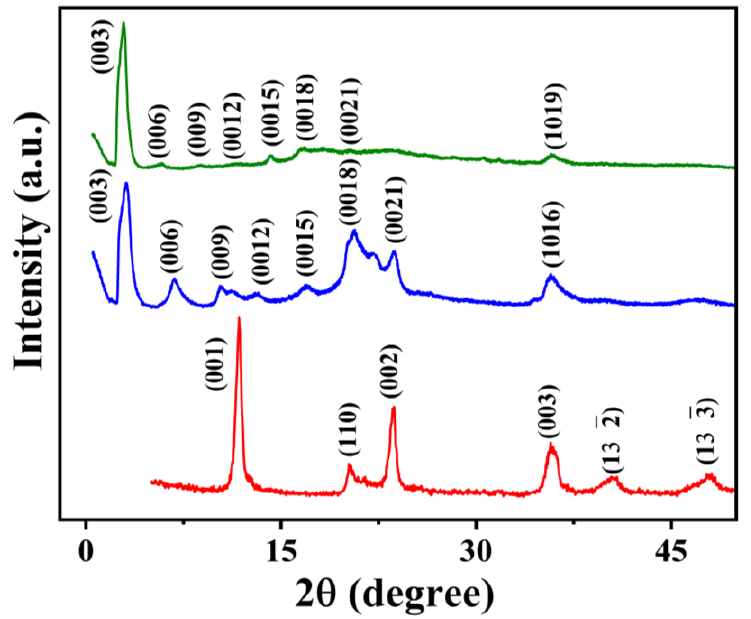
Figure 1. Powder XRD patterns of pristine LDH ([LiAl 2 (OH) 6 ]OH · 2H 2 O) (data in red), Li-Al-DS LDH (data in blue), and Li-Al-DBS LDH (data in olive green).